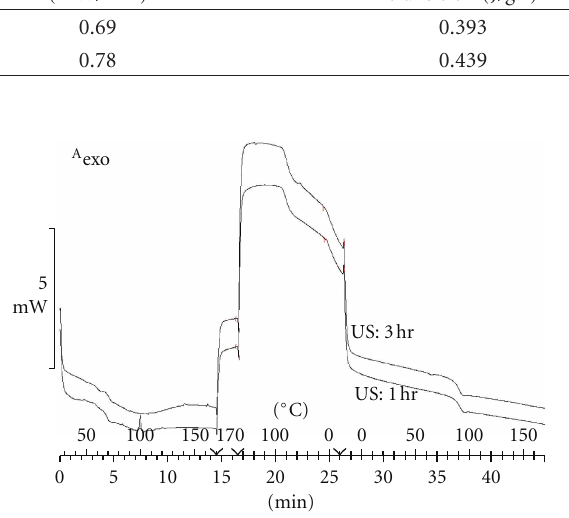
Figure 3: The DSC diagram of epoxy clay nanocomposite prepared by mechanical stirring and ultrasonic treatment for 1 and 3-hour